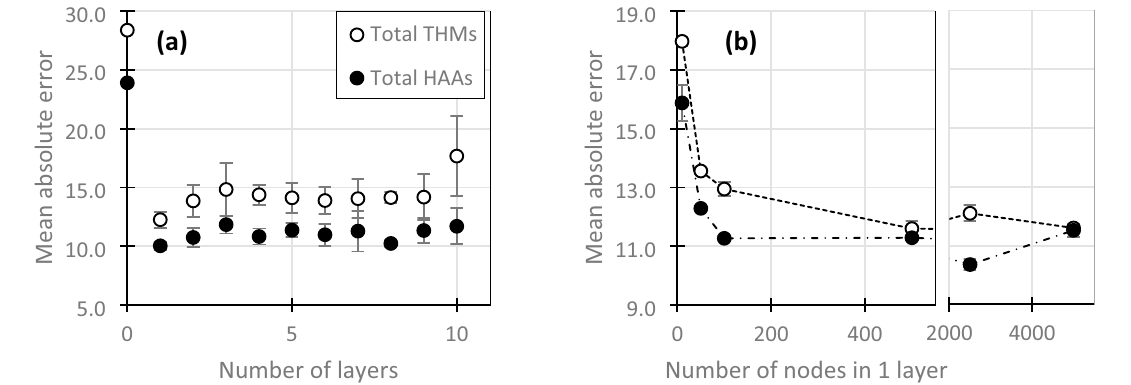
Figure 1. Mean absolute error (MAE) of prediction for a test set (n = 28) of THM concentrations and HAA concentrations using a MLP. ( a ) The effect of number of layers on performance, ( b ) the effect of number of nodes in 1 hidden layer on performance. Error bars represent 95% confidence intervals based on 8 random initializations of the network weights.